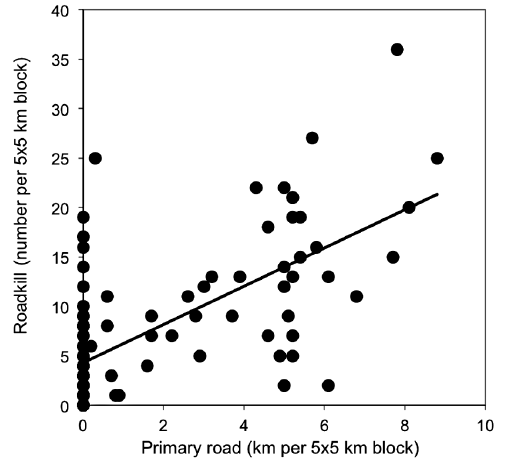
Fig. 10 . Relationship between the amount of primary road per 25 km² and the number of road casualties. The more primary road is present, the more roadkill can be expected (Pearson correlation test; N = 150, r² = 0.43, ts = 10.5, p < 0.001).